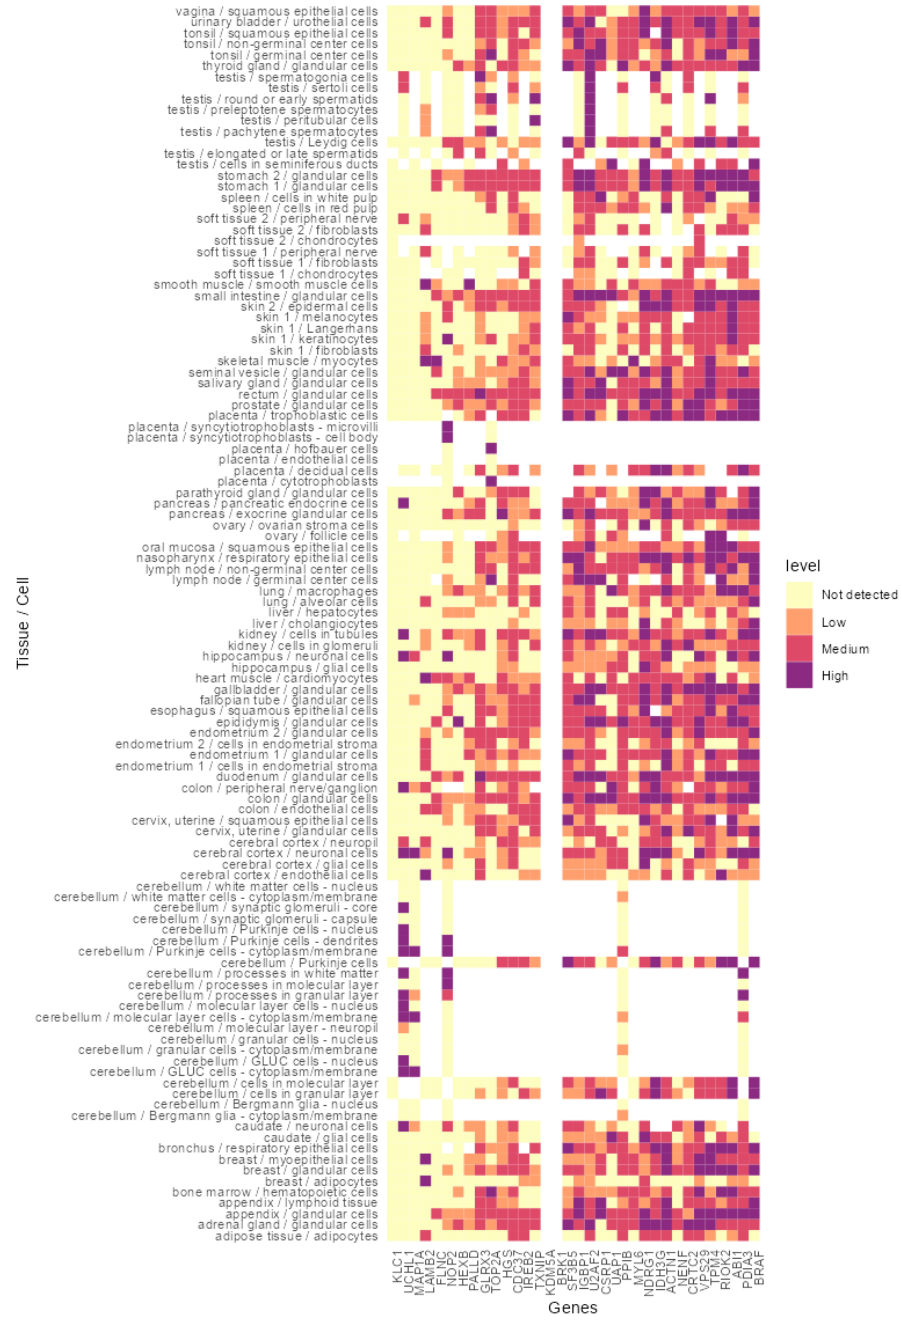
Figure 4. In silico analysis of the antigens revealed the levels of expression in normal tissues. Target antigens derived from p53-R175H and p53-R273H mutants and common to both HLA fractions (Pan-HLA and HLA-A2) were checked for their normal tissue expression. Heatmap showing the expression levels of each protein in normal cells. The purple, red and orange colors indicate very high to low levels of expression, pale yellow represents no expression detected, and white repre- sents no data available in the corresponding histology in Human Protein Atlas.